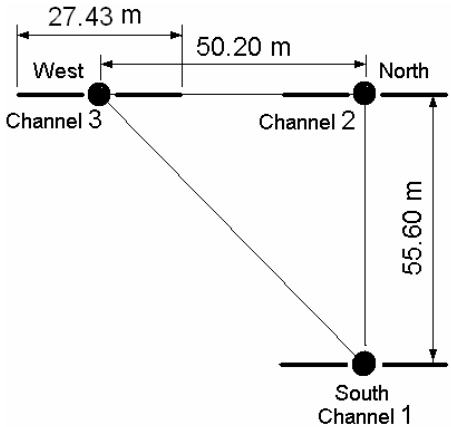
Fig. 3. The absolute angle between the direction of the center of the HF antenna beam and the geomagnetic field for beam directions 0 ◦ , 7 ◦ , 14 ◦ , and 21 ◦ south at an altitude of 250km. The center of the beam, which is 13.6 ◦ wide at half power, does not quite reach field-aligned because of the orientation of the HF antenna along geographic